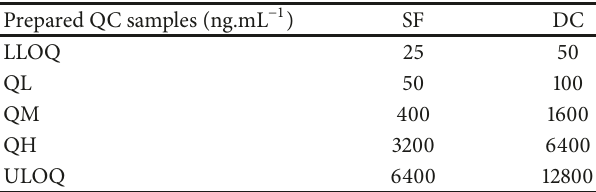
Table 1: Quality control samples for SF and